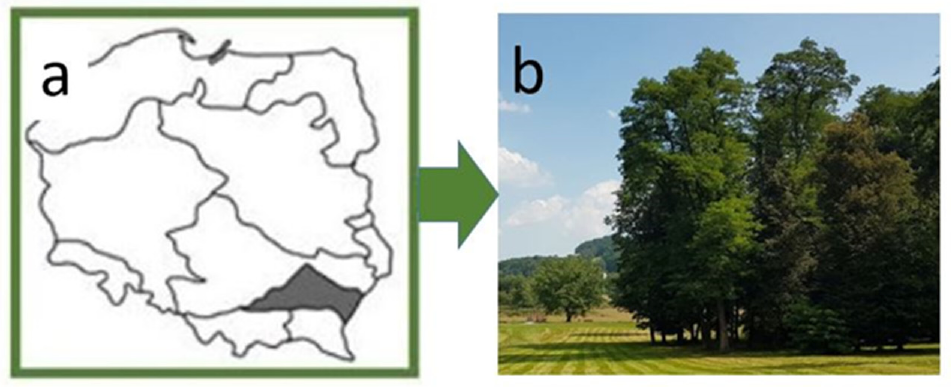
Figure 1. Localization of manor parks in the Sandomierska Basin, Poland ( a ), the example of a manor park with a forest ( b ).